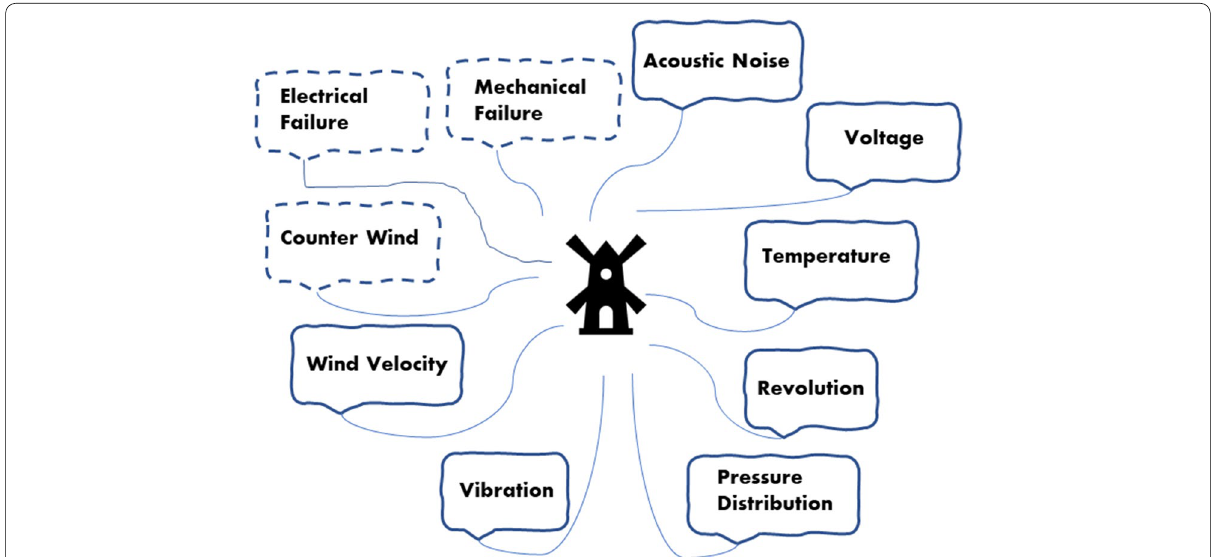
Fig. 1 A cyber‑physical model is expected to sufficiently explain the effect of real‑world elements such as acoustic noise, mechanical failure, temperate change, revolution (rpm), the pressure distribution of blades, vibration, counter‑wind occurrence, and wind velocity,